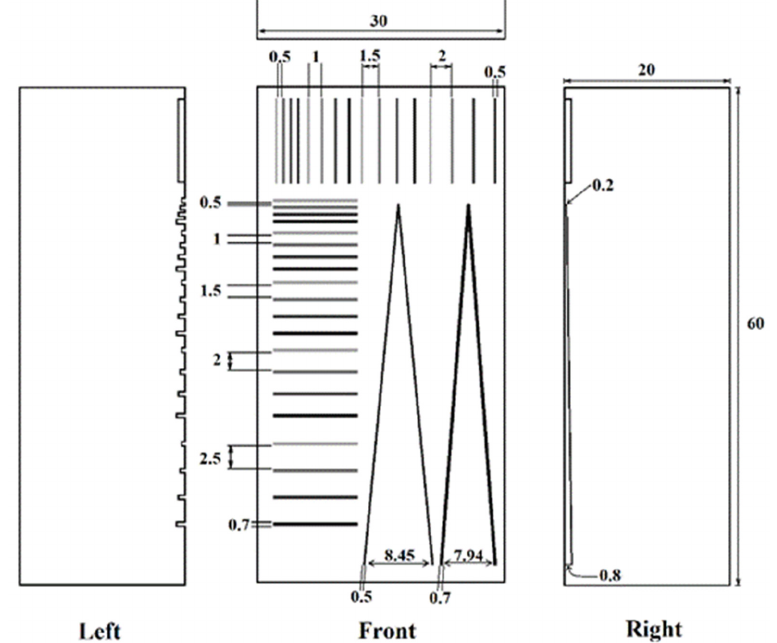
Figure 1. Slit gauge.